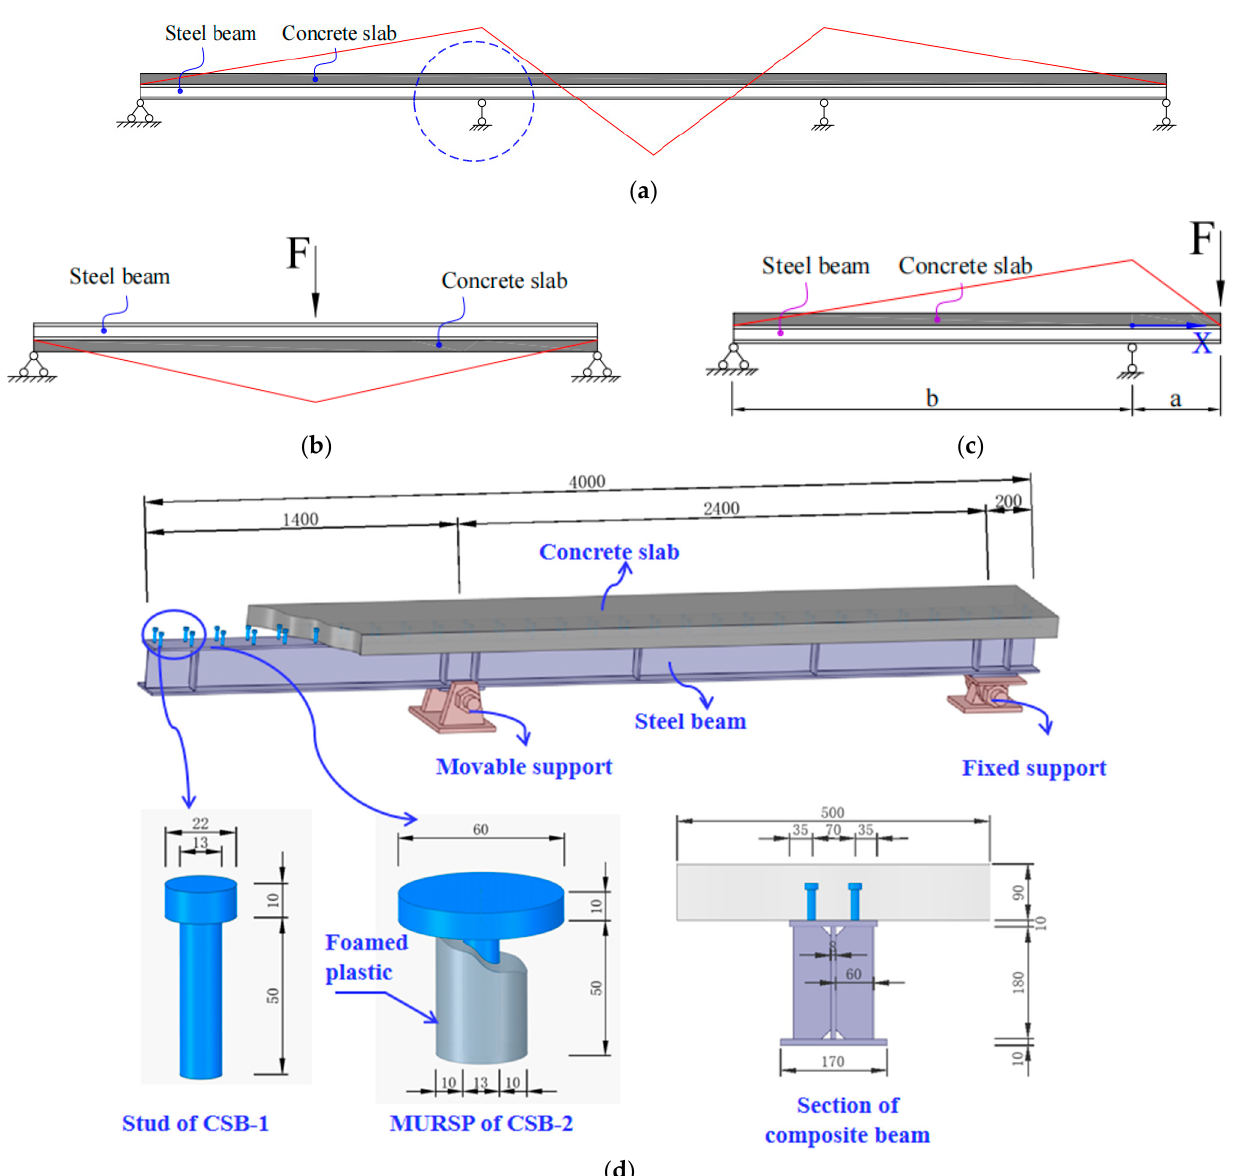
Figure 1. Structure of the overhanging SCCBs. ( a ) Negative moment region of a continuous beam. ( b ) Overturned simply supported beam. ( c ) Overhanging beam. ( d ) Dimensions of the test specimen.